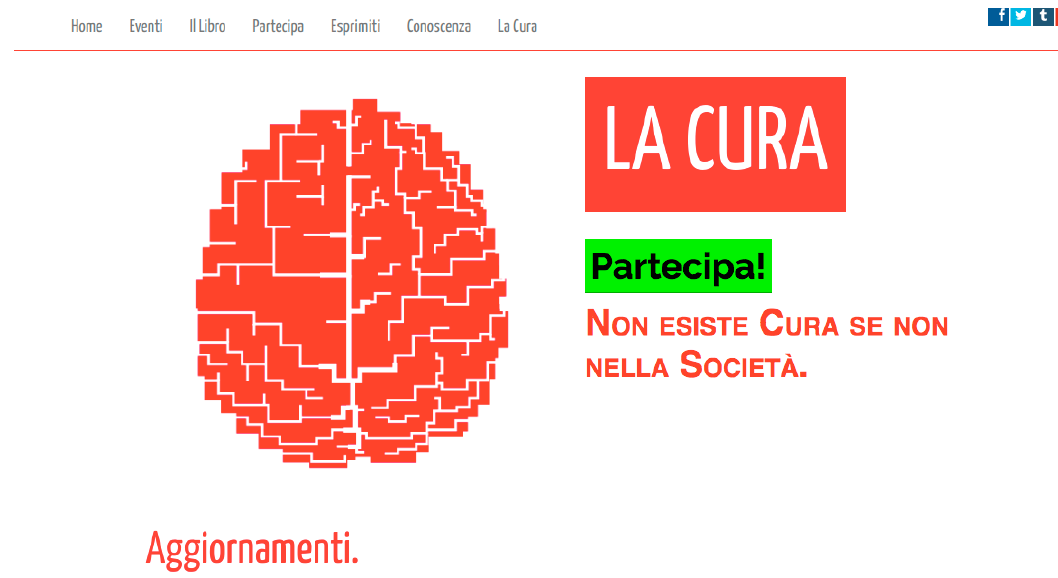
Figure 1. “La Cura” project screenshot from the Webpage http://la-cura.it. Courtesy of the author.